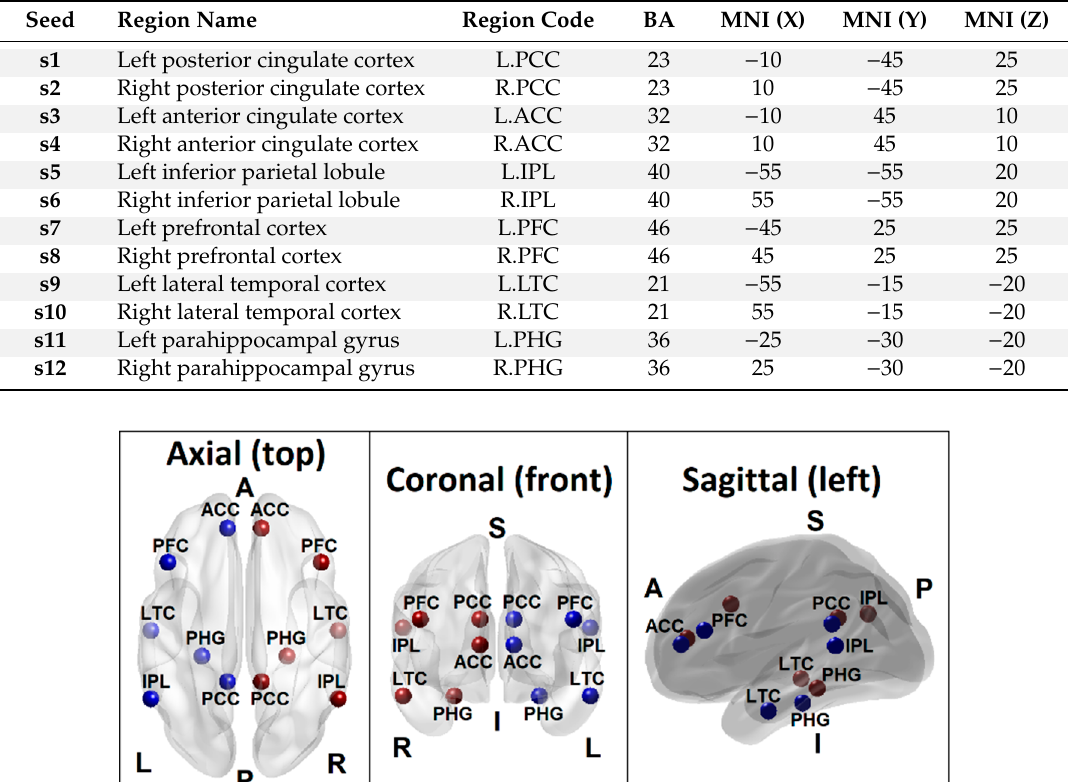
Table 2. Default mode network (DMN) seed regions, Brodmann Areas (BA) and the Montreal Neurological Institute (MNI) Coordinates.